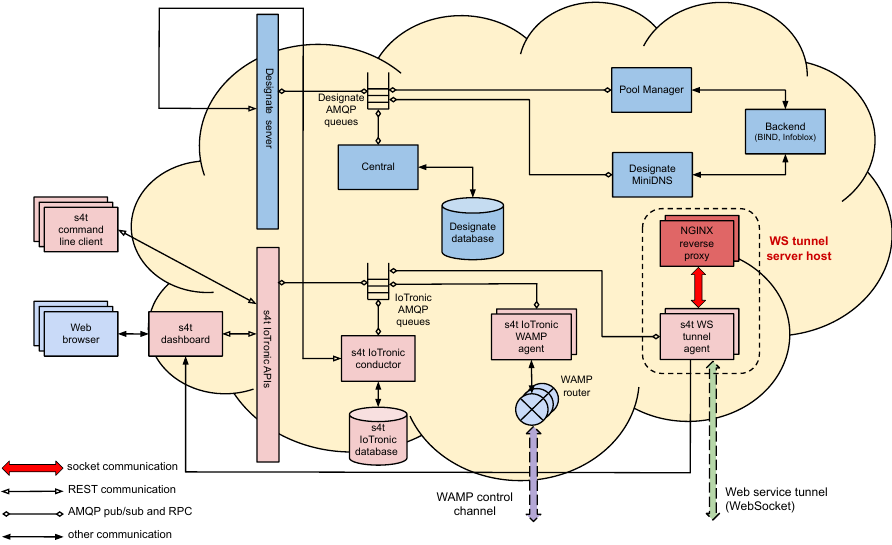
Figure 9. The S4T cloud-side web services system.